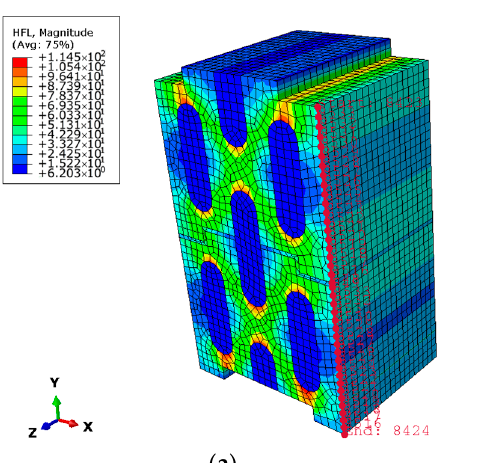
Table 4. Heat transfer coefficient between the model and reference.